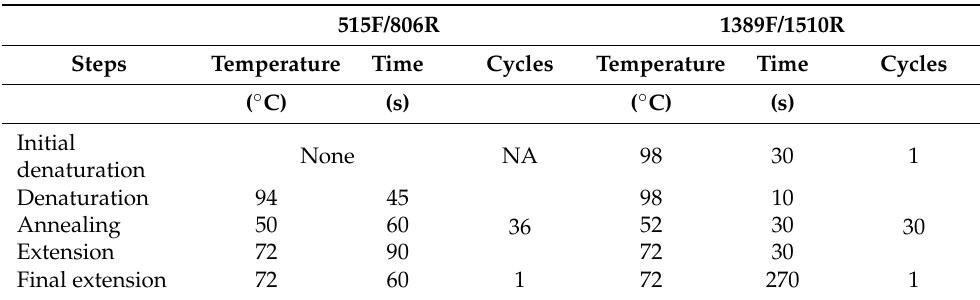
Table 1. PCR thermal cycling conditions for the sets of primers 515F/806R (prokaryotes) and 1389F/1510R